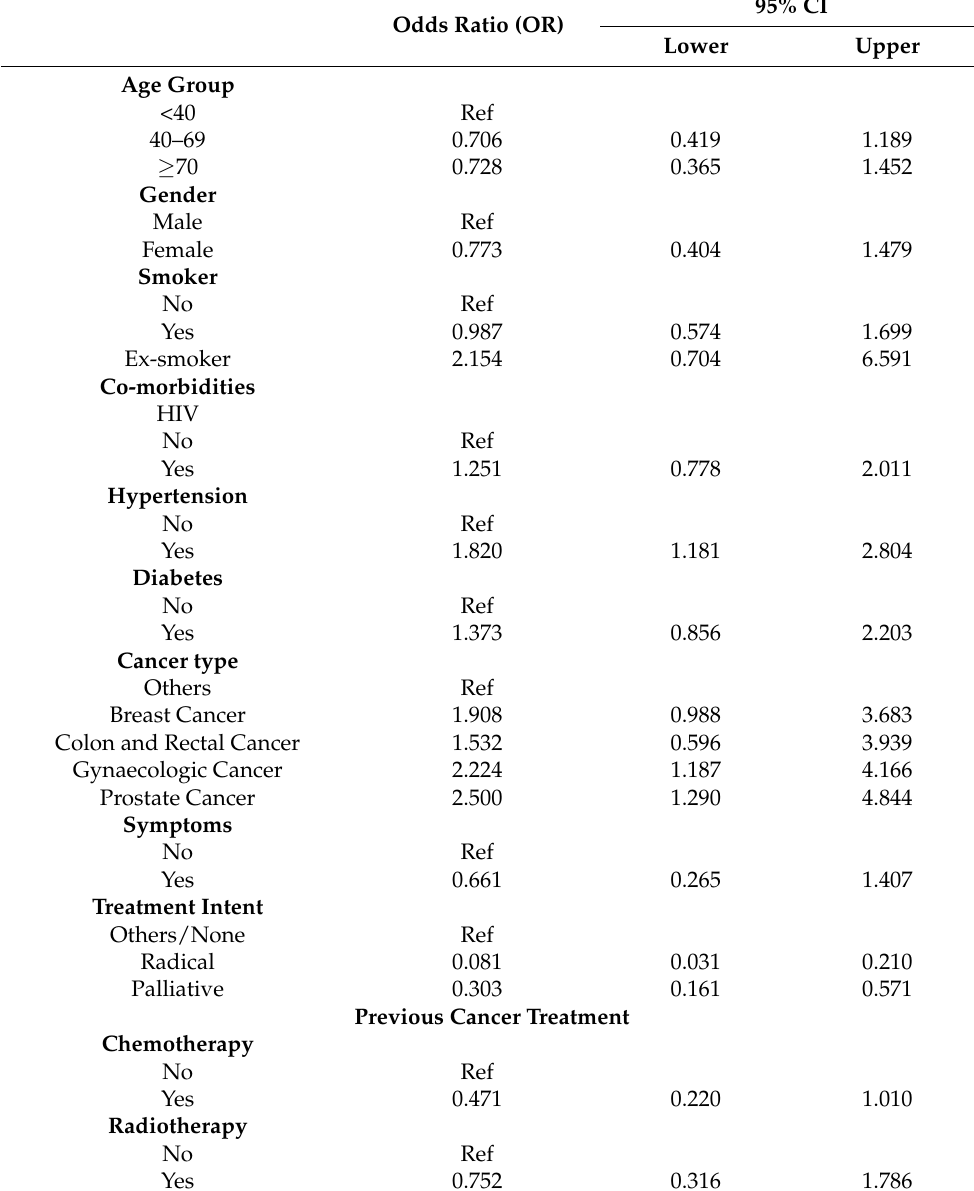
Table 4. Binary logistic regression analysis of factors associated with seropositivity.